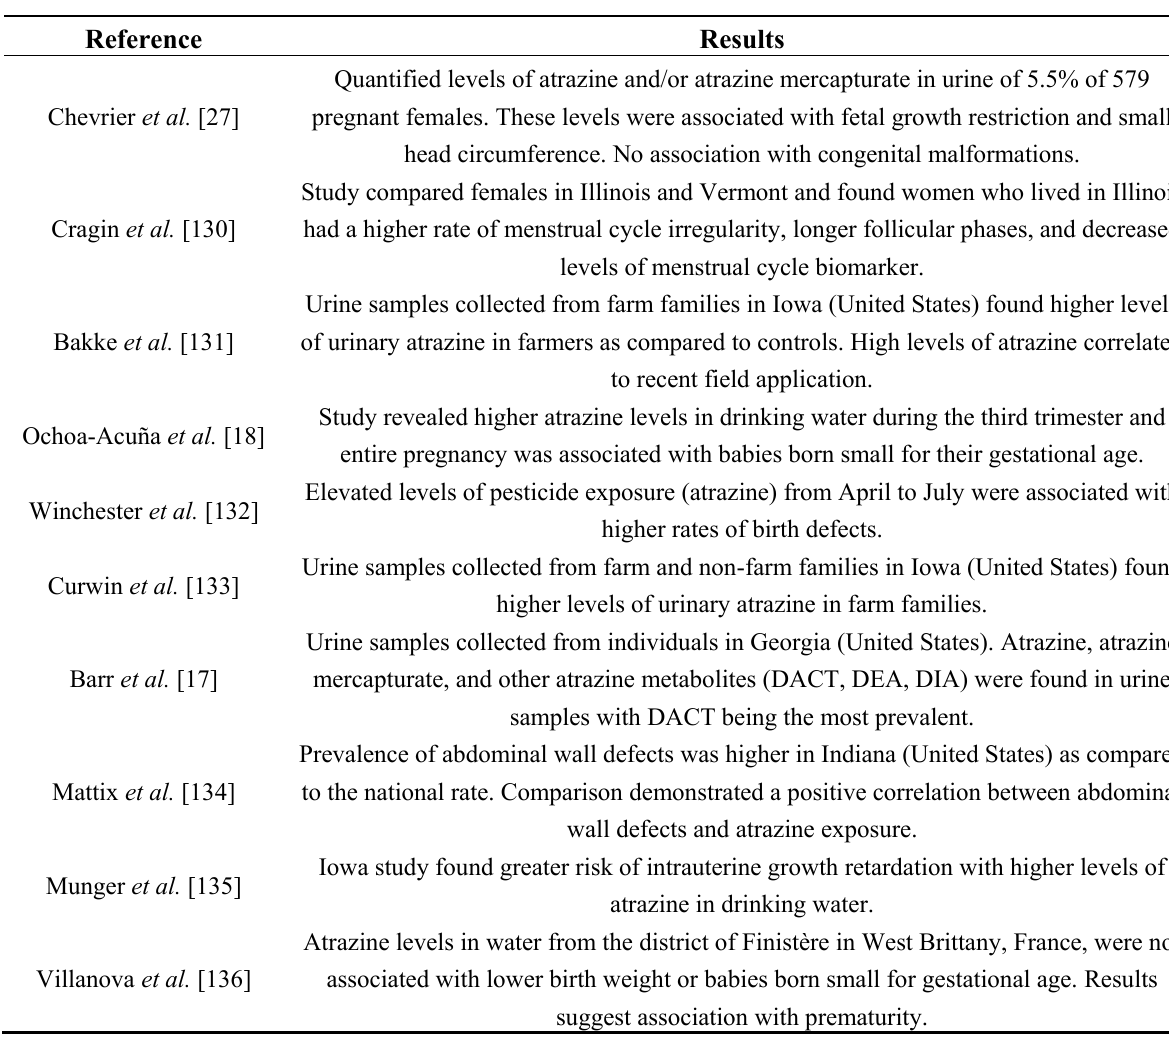
Table 4. Epidemiological studies addressing reproductive alterations associated with